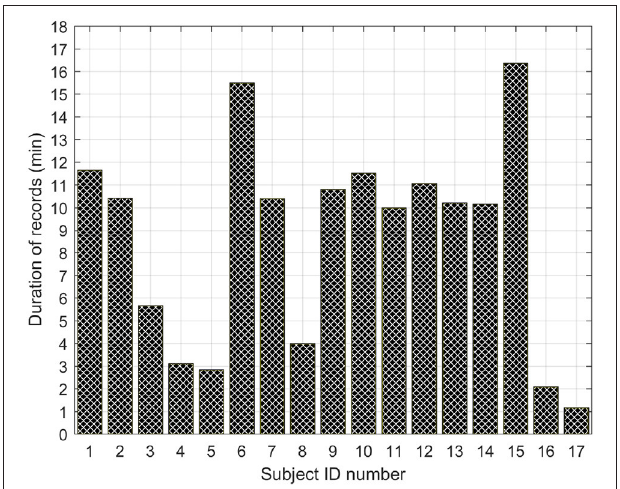
FIGURE 1 | Duration in minutes of the total number of records per